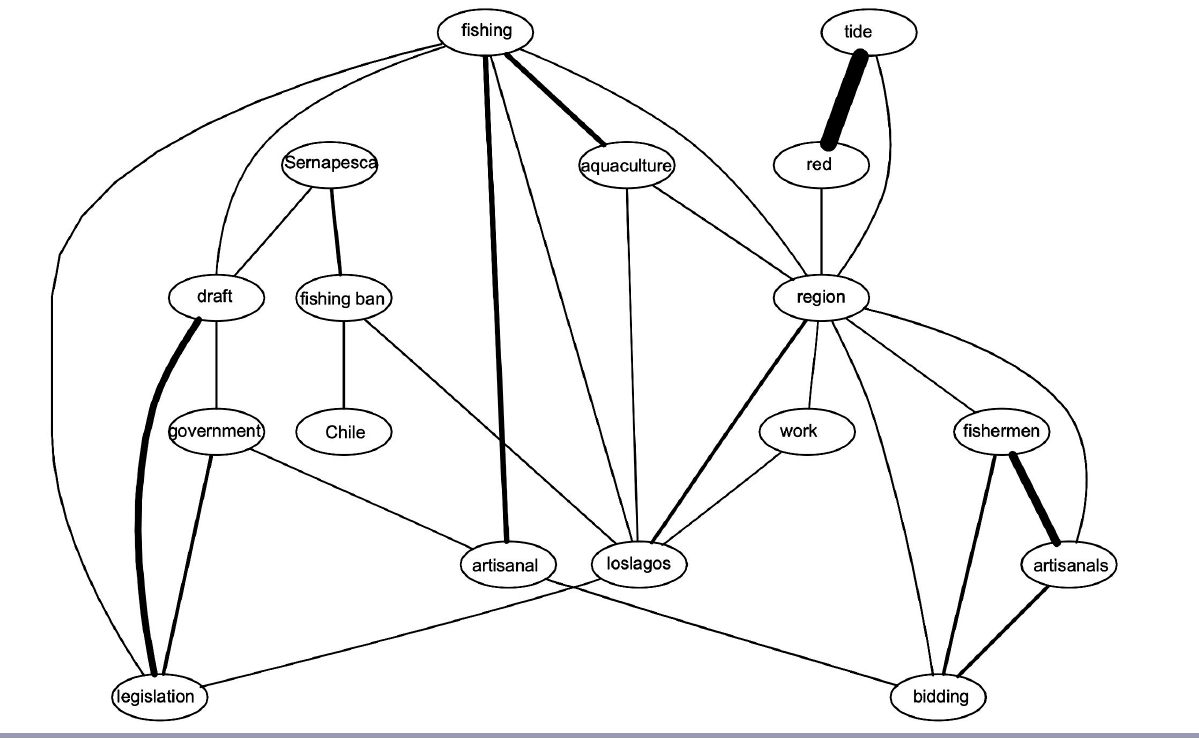
Fig. 5 . Main communication topics after the crisis: June 2016 to January